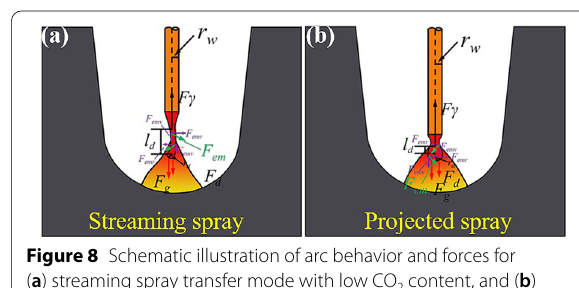
Figure 8 Schematic illustration of arc behavior and forces for ( a ) streaming spray transfer mode with low CO 2 content, and ( b ) projected spray transfer mode with high CO 2